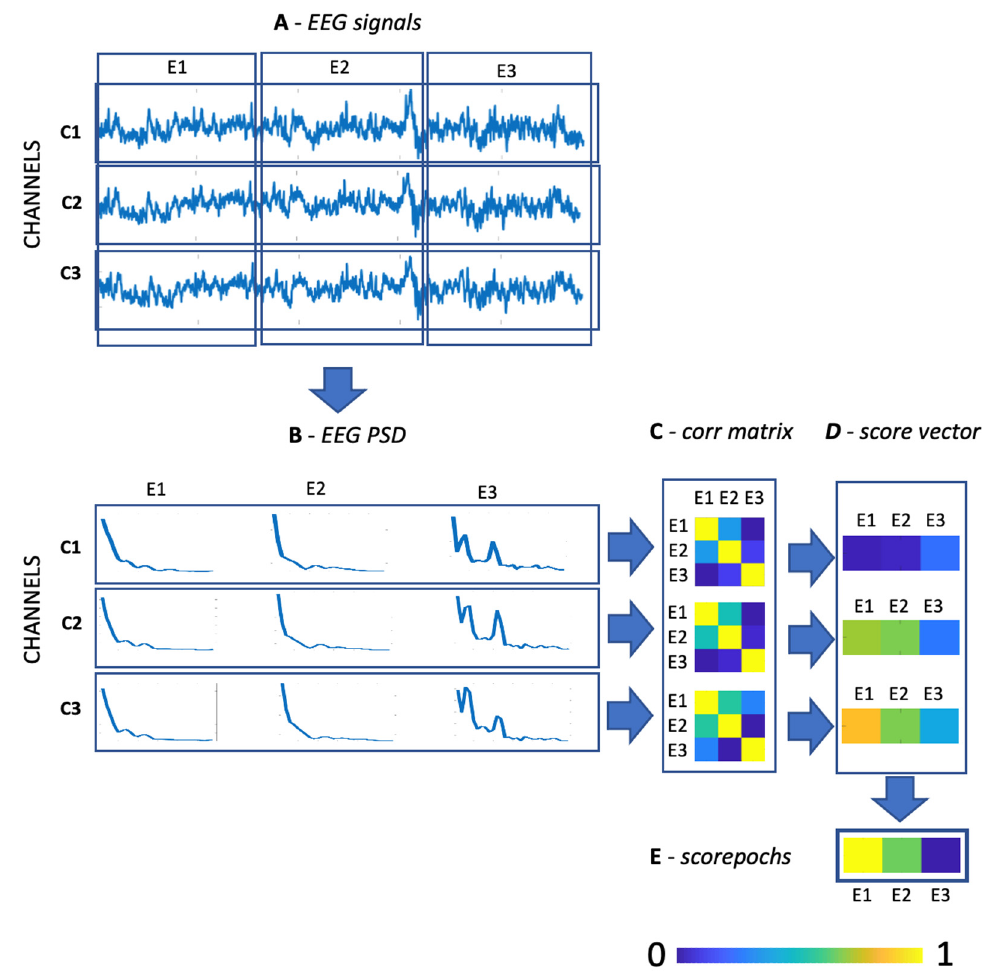
Figure 1. A schematic representation of the algorithm used to compute Scorepochs: ( A ) EEG raw signals of three channels with an epoch scheme; ( B ) power spectral density plots for each channel and each epoch; ( C ) correlation matrices for each channel; ( D ) score vector for each channel and for each epoch; ( E ) score for each epoch.